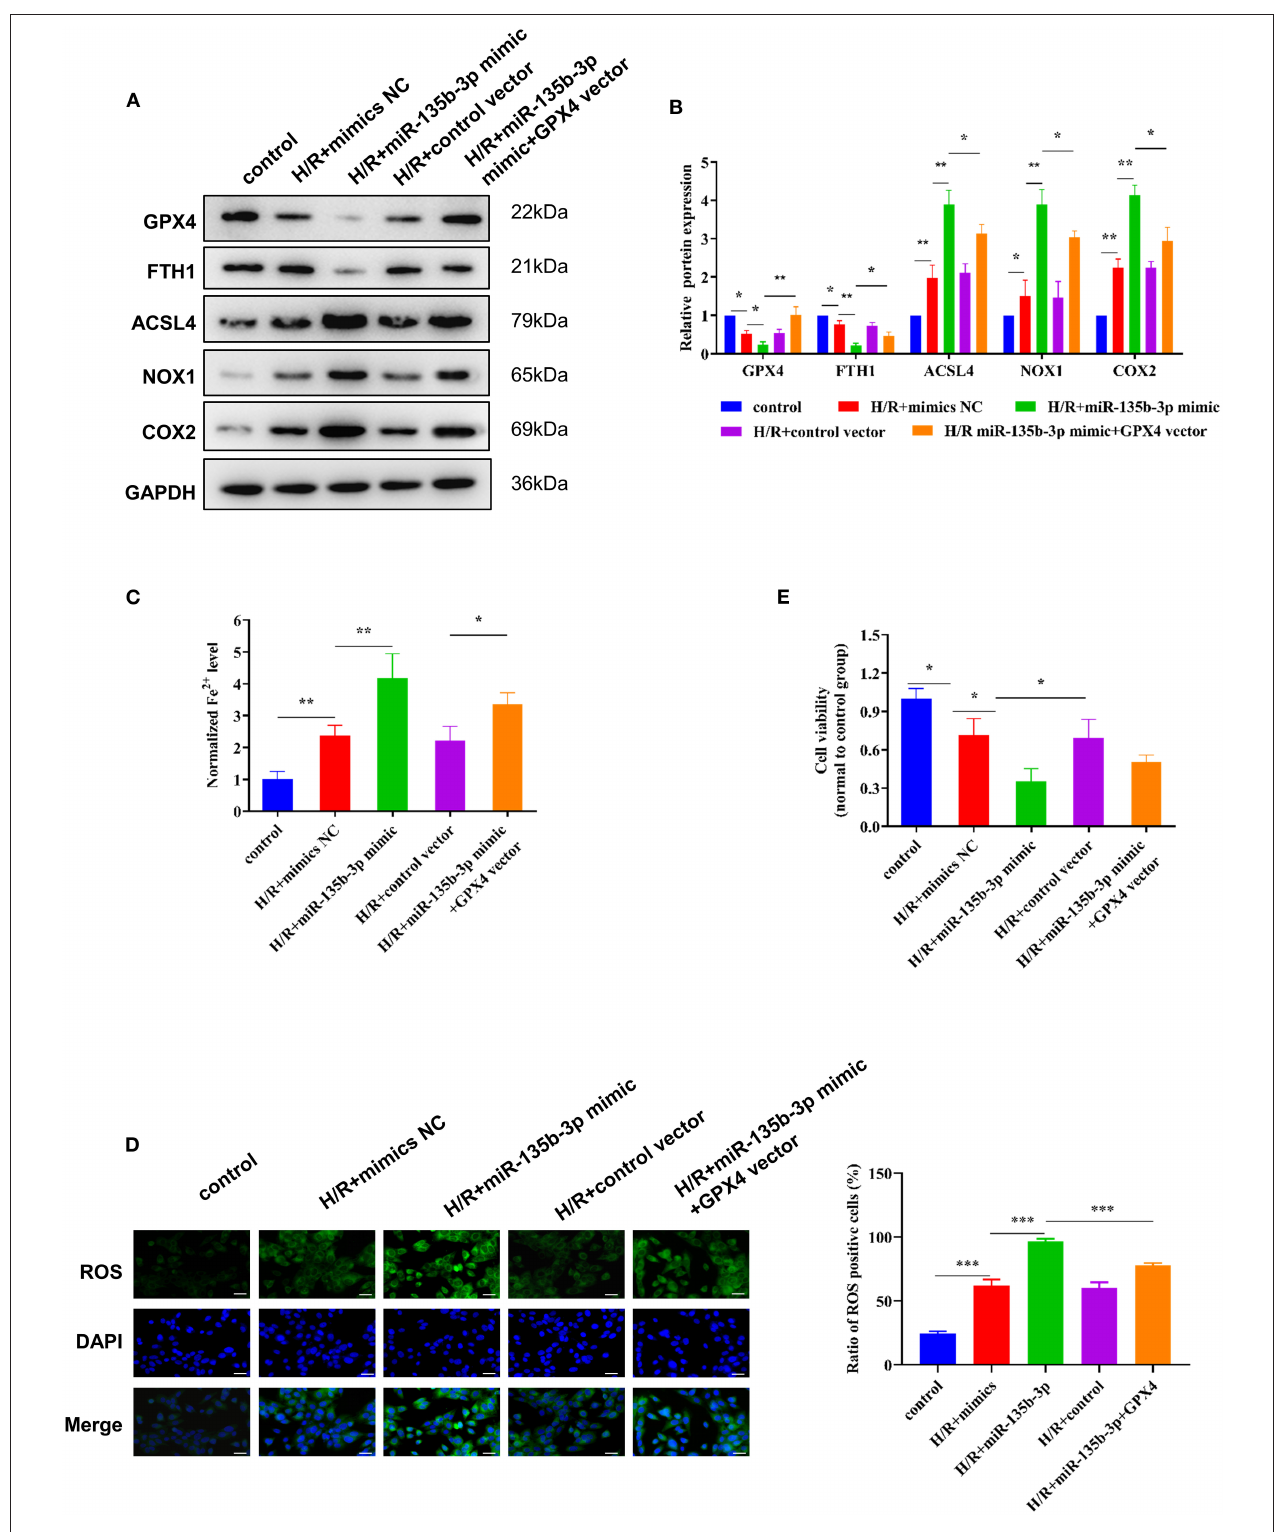
FIGURE 5 | miR-135b-3p promotes ferroptosis through inhibition of GPX4 expression in H9C2 cells after H/R. This part of the study was based on untreated H9C2 cells and H/R-treated H9C2 cells, where miR-135b-3p and GPX4 expression was altered in H/R H9C2 cells ( n = 3). (A) Western blots indicating the levels of